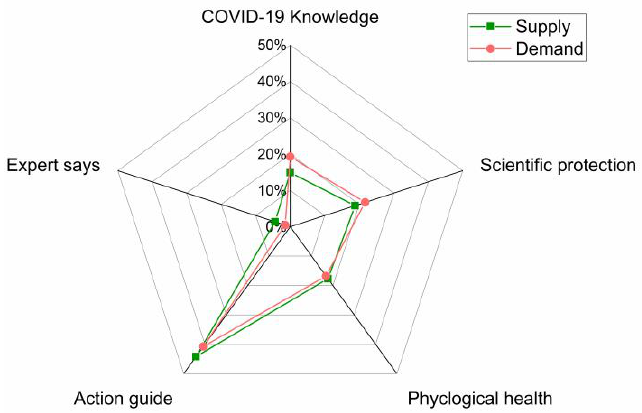
Figure 11. The degree of information matching between supply and demand in the outbreak stage.